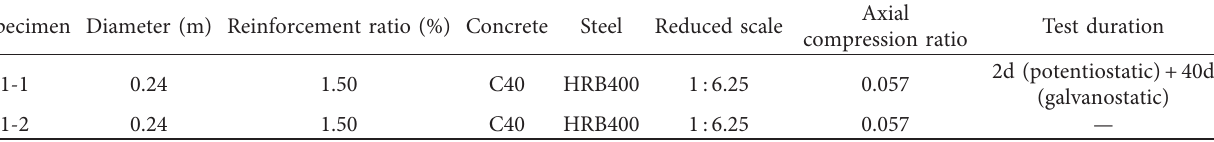
Table 6: Specimen parameters and test matrix.